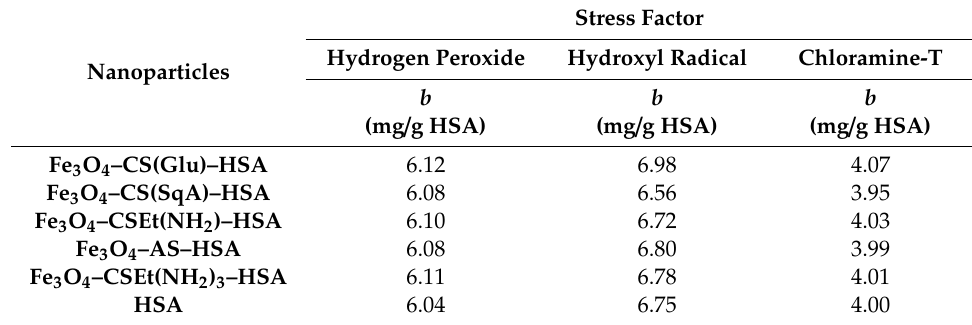
Table 5. Results of immobilized HSA interaction with KP solution after oxidative stress induced with di ff erent stress